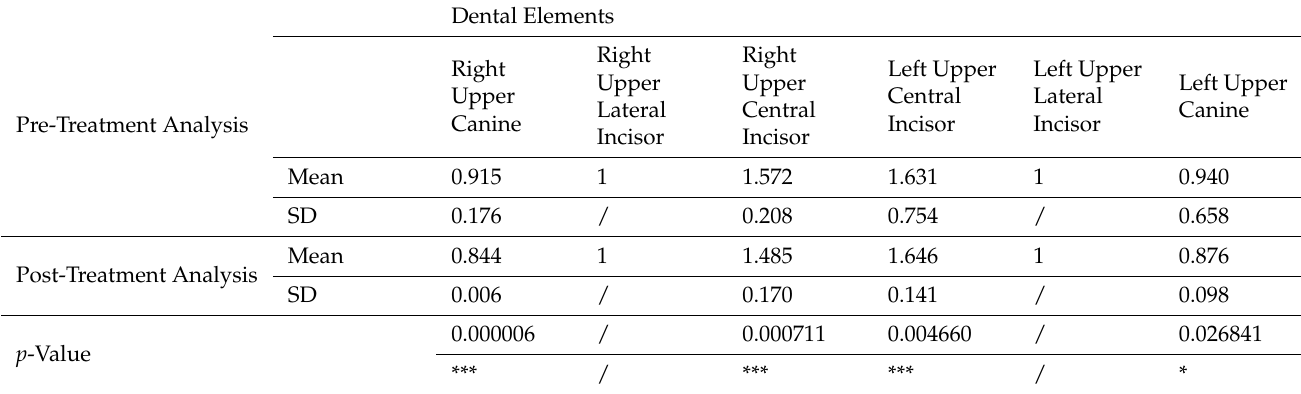
Table 1. Sample values calculated by applying GP theory (Levin).